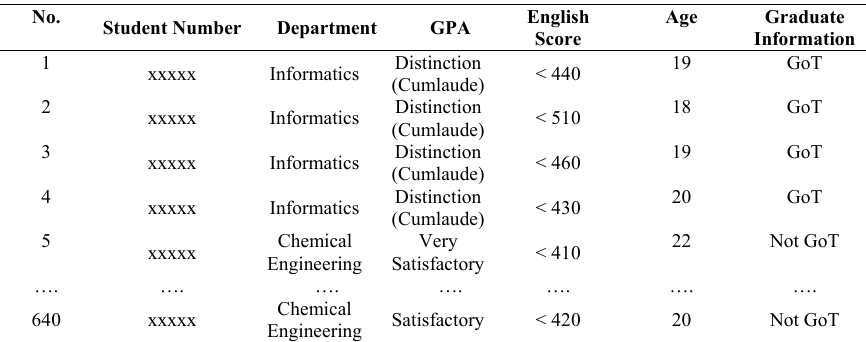
TABLE 2 D ATA P RE - PROCESSING R